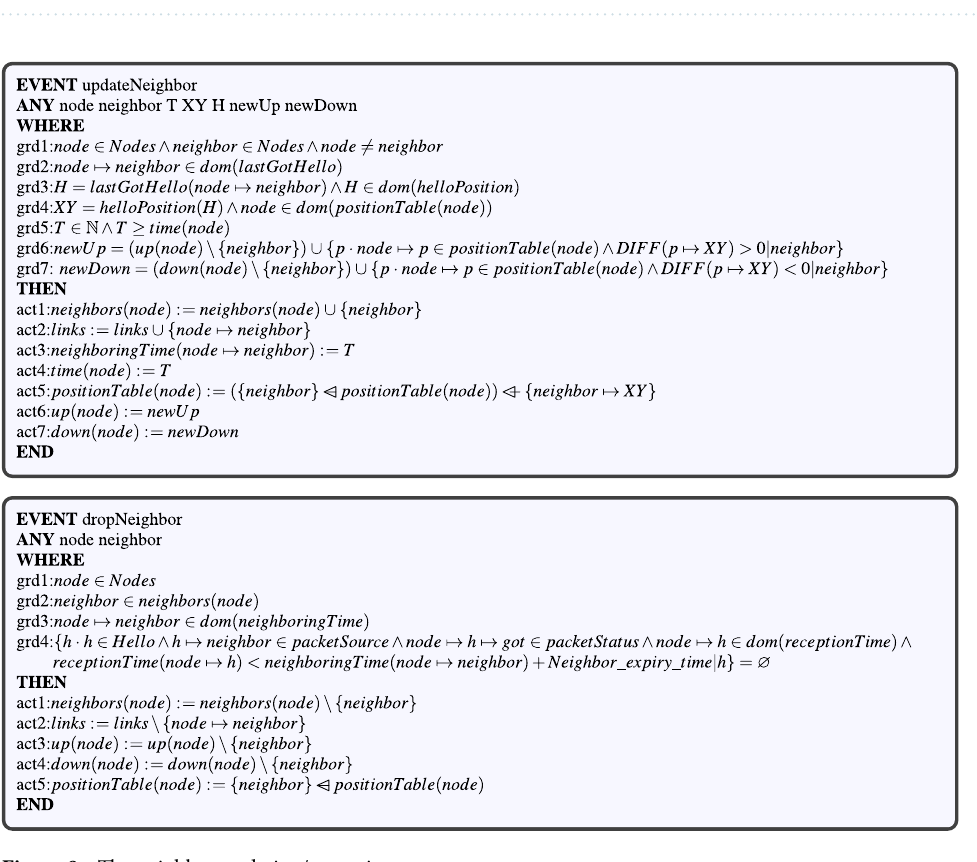
Figure 7. Updating vehicles position event.